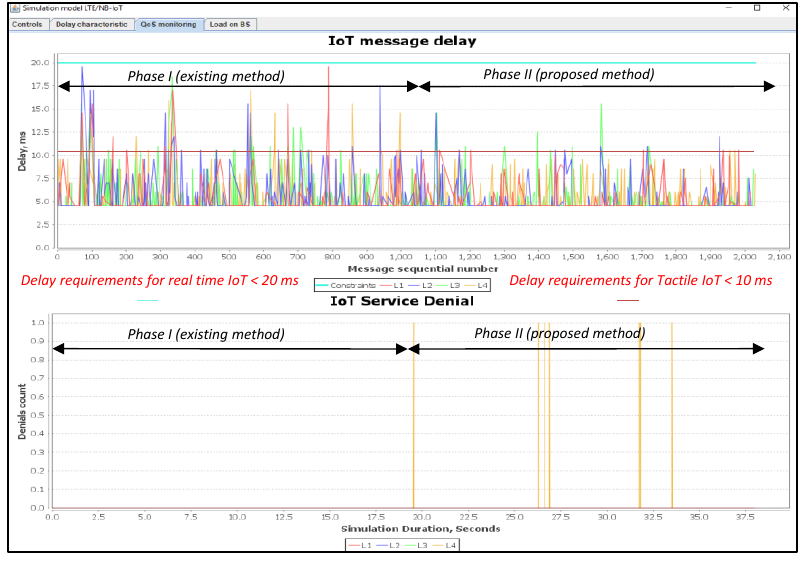
Figure 11. Delay and service denial values when serving requests from IoT devices (average load of IoT controller ρ = 12%).